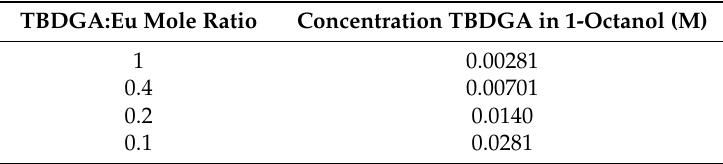
Table 3. TBDGA solutions, Eu:TBDGA mole